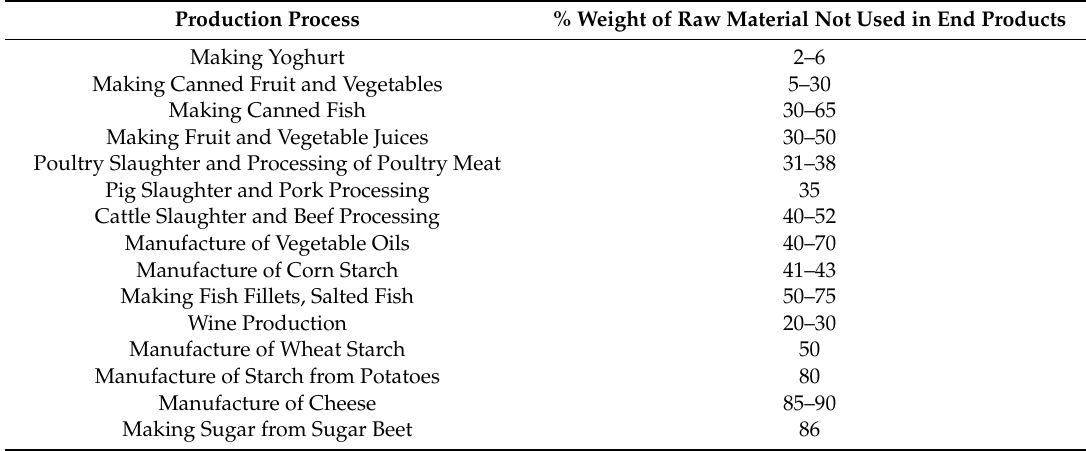
Table 1. Percentage of unused raw material in various branches of food production